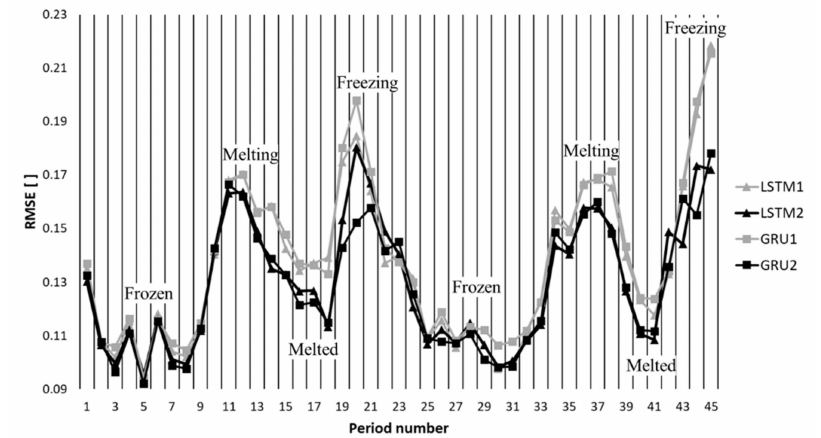
Figure 6. RMSE in the test